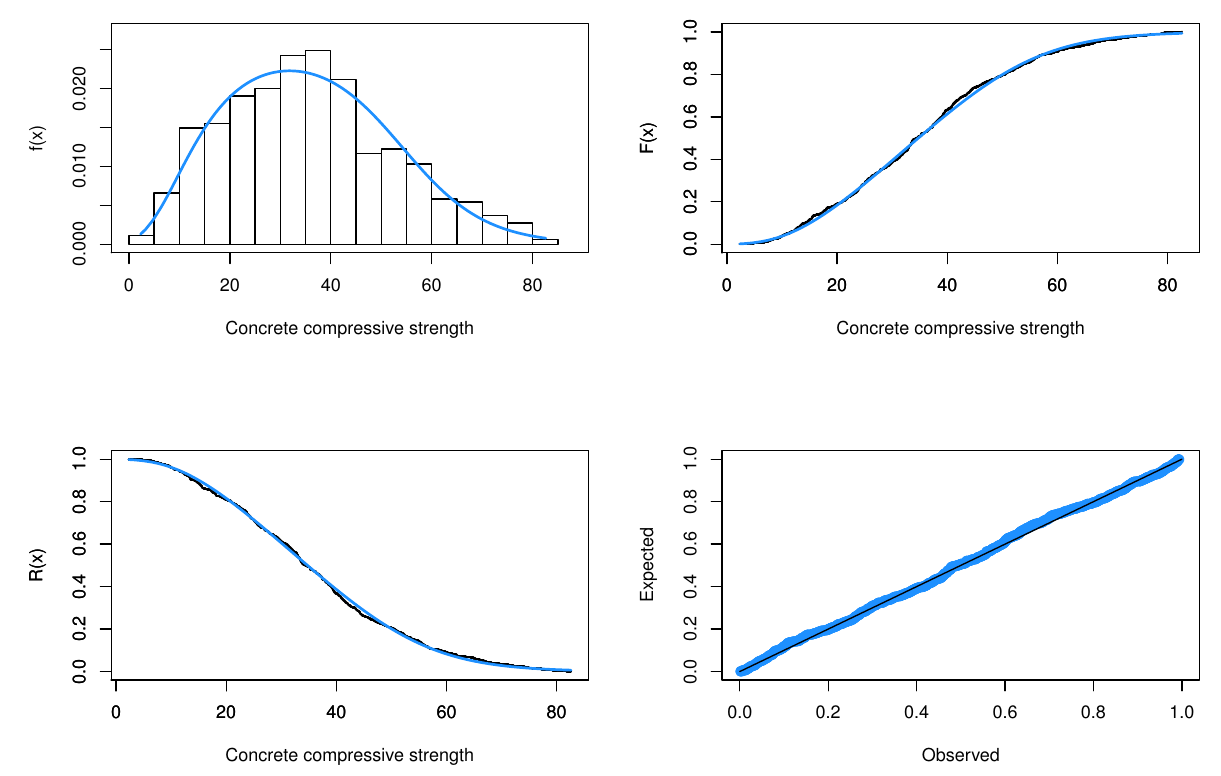
Figure 5. Plots of fitted functions and PP plot of the LTAPEx distribution for concrete compressive strength data. Table 8. MLEs, standard errors (in parentheses) and goodness of fit statistics for real data.